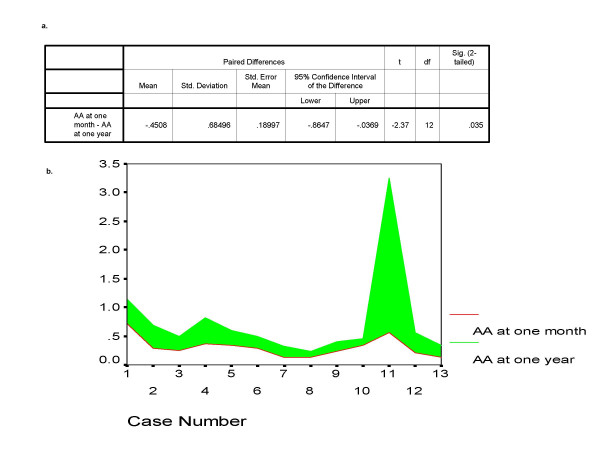
Progression in AA scores between patients one month and 12 months after surgery; a. Paired Samples Test, b. Differences graphically displayed